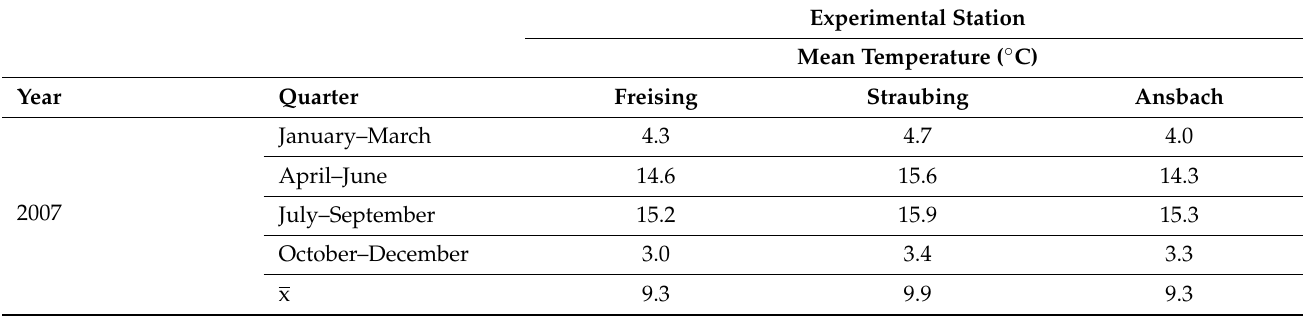
Table A2. Mean trial year temperature at the experimental